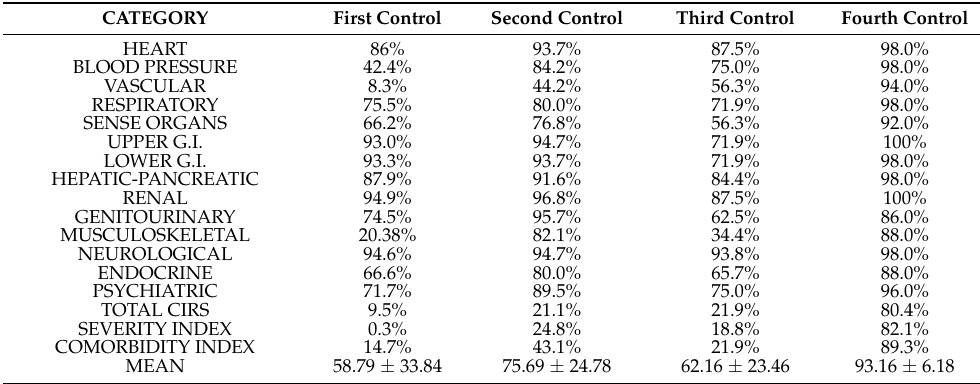
Table 5. Levels of agreement for all phases of